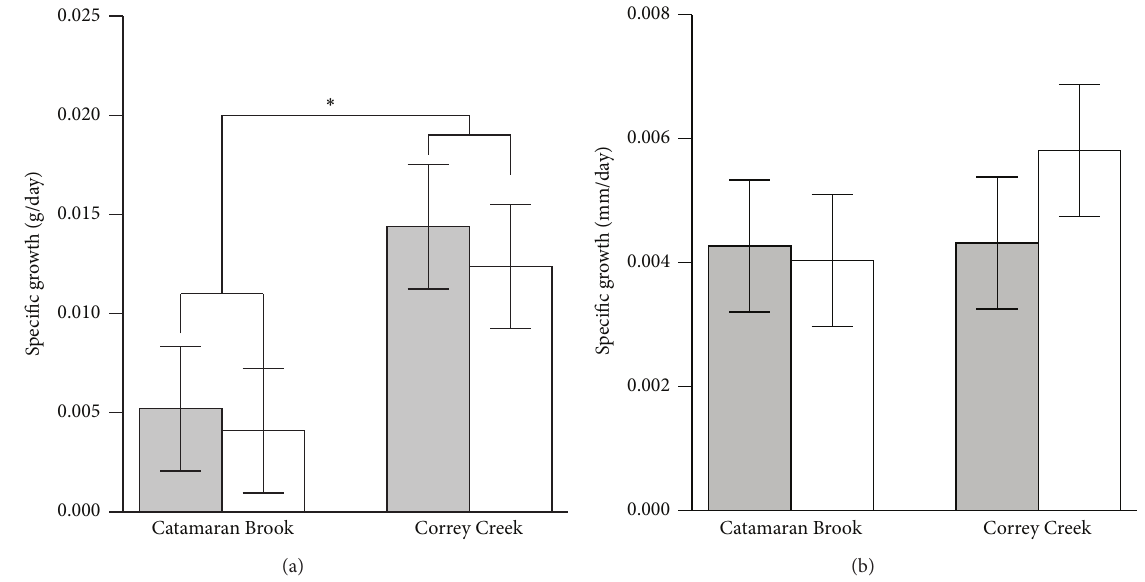
Figure 3: Mean ( ± SE) specific growth rates of wild-caught 0 + Atlantic salmon ( Salmo salar ) fry from Catamaran Brook in their neutral natal stream or transplanted into acidic Correy Creek. Changes in (a) weight (g) and (b) standard length (mm) over 8 days with daily exposure to injections of damage-released chemical cues (shaded bars) or a stream water control (open bars; 𝑛 = 30 measurements per bar). Asterisks denote significant differences between streams from 1-way ANOVA ( ∗ 𝑃 < 0.05